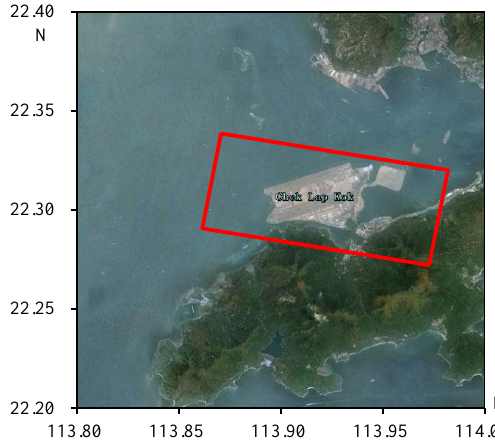
Figure 4. Geographic location of TerraSAR-X data of the Hong Kong airport.